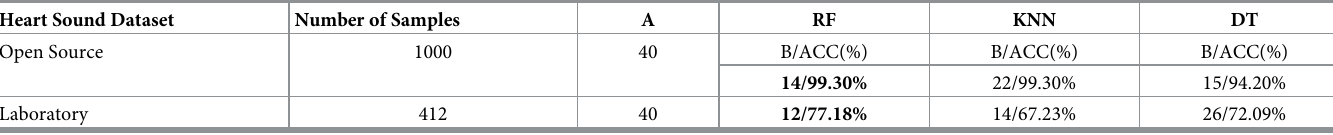
Table 10. The best accuracy and number of selected minimum features by adaptive HD